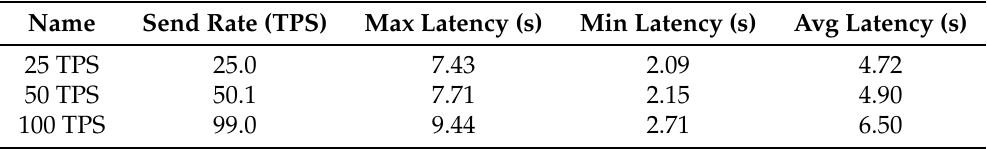
Table 3. Benchmarks on RPi3: send rate and latencies in seconds (s).